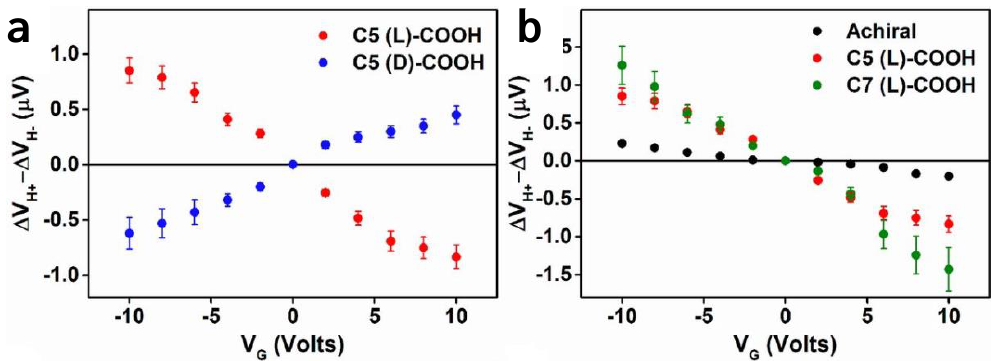
Figure 9. Hall measurements conducted on devices coated with different oligopeptides. ( a ) Hall potential measured when the adsorbed layer is either L-SH-CH 2 -CH 2 -CO-{Ala-Aib} 5 -COOH (red) or D-SH-CH 2 -CH 2 -CO-{Ala-Aib} 5 -COOH (blue). ( b ) The dependence of the Hall voltage on V G is shown for monolayer films of achiral 11-mercapto-undecanoic acid (black), chiral L-SH-CH 2 -CH 2 -CO-{Ala-Aib} 5 -COOH (red), and chiral L-SH-CH 2 -CH 2 -CO-{Ala-Aib} 7 -COOH (green) (Reproduced with permission from [6], United States National Academy of Sciences, 2017).